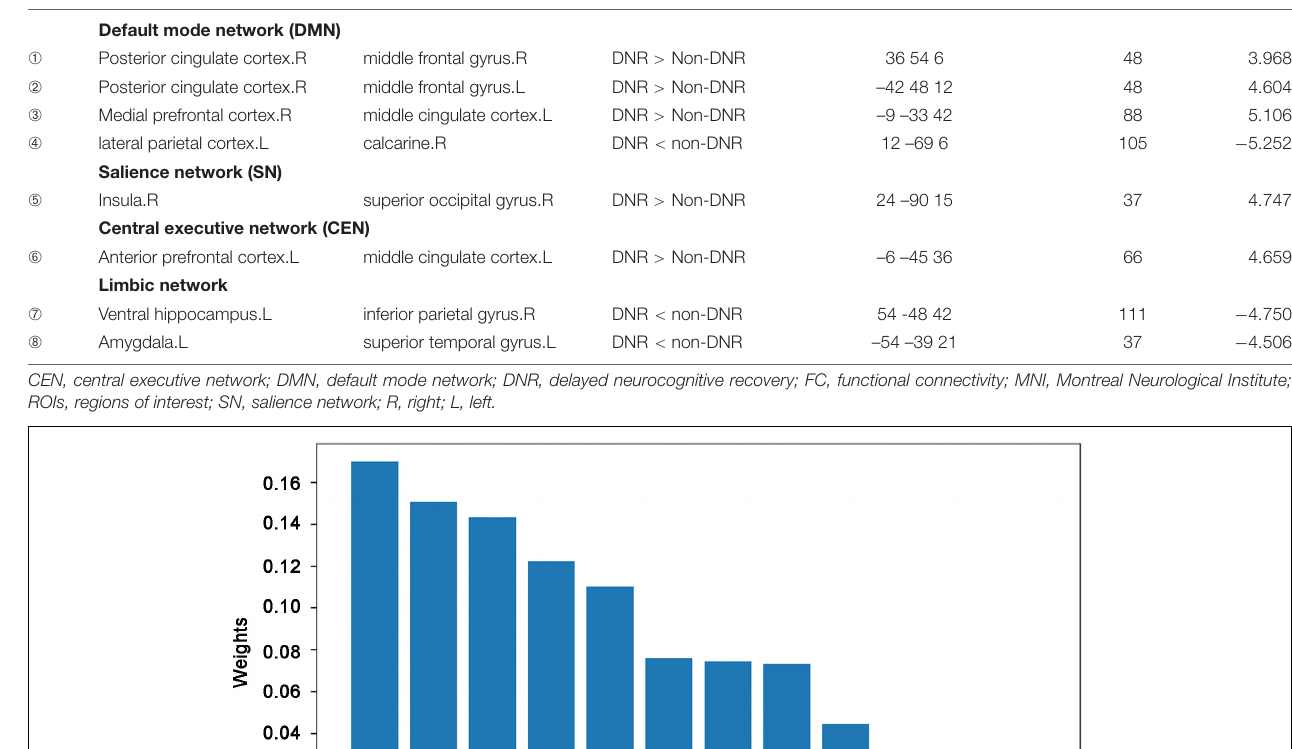
RF algorithm using rs-fMRI data combined with age, sex,